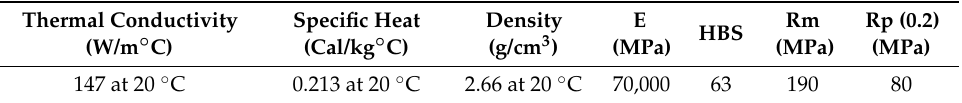
Table 2. Physical properties of AA5754 H111.